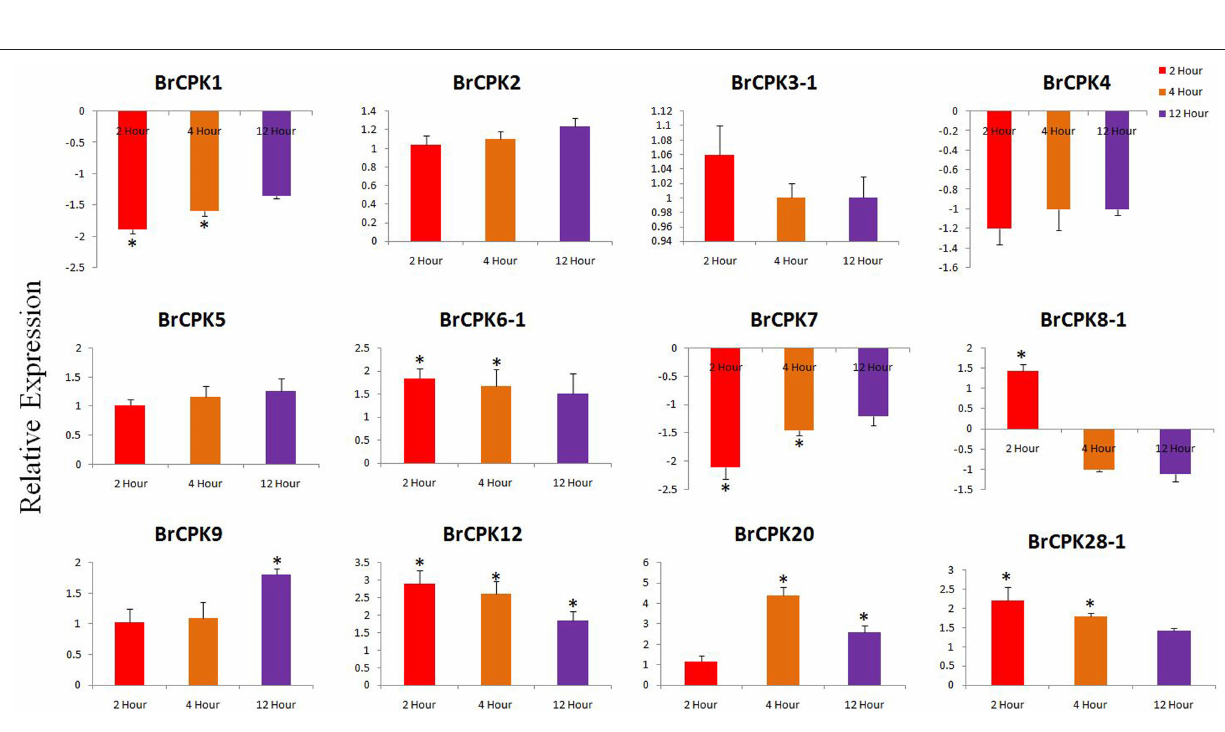
FIGURE 7 | Quantitative real time PCR of drought treated B. rapa CPK genes at 2, 4, and 12h. The transcript levels were normalized with EF1 and ACT2 and expressed as fold change relative to normalized transcript levels in leaves of control (untreated plats in respective time point) plants. The metric bar represents the standard errors (SE) and star indicates statistical significance at * p < 0.05